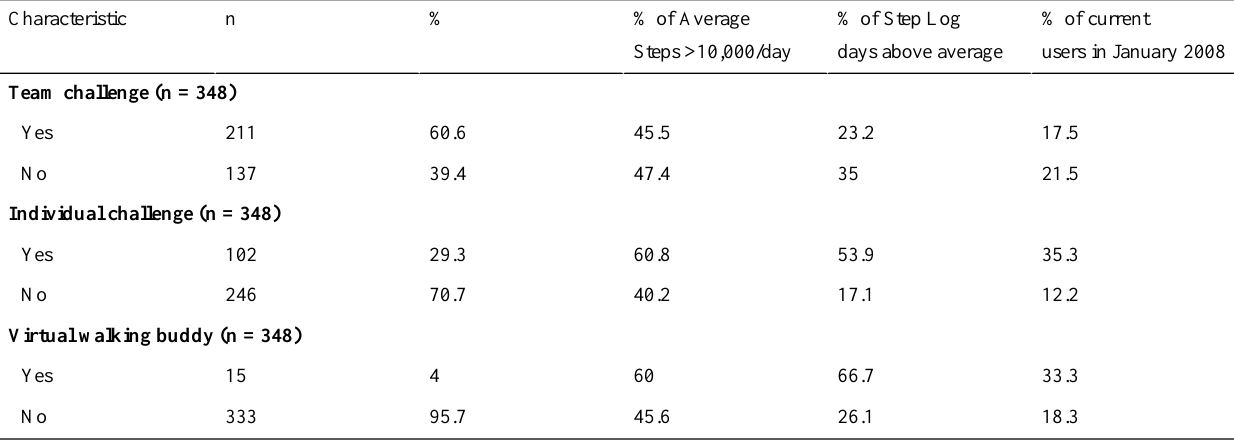
Table 2. Descriptive summary of objective website